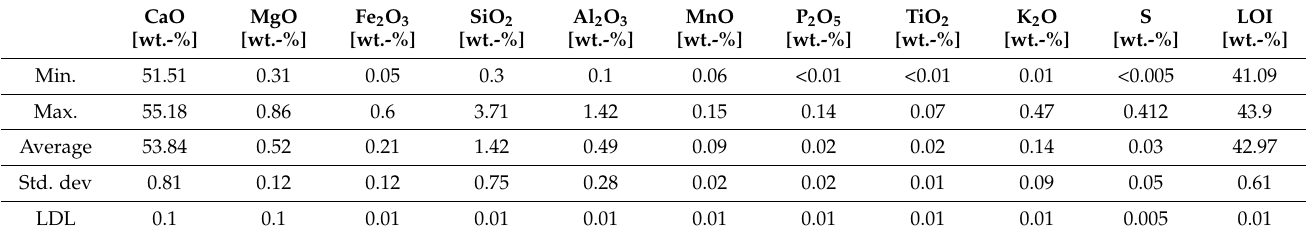
Table 2. The average chemical composition (XRF) and LOI values of 80 Jutjärn limestone